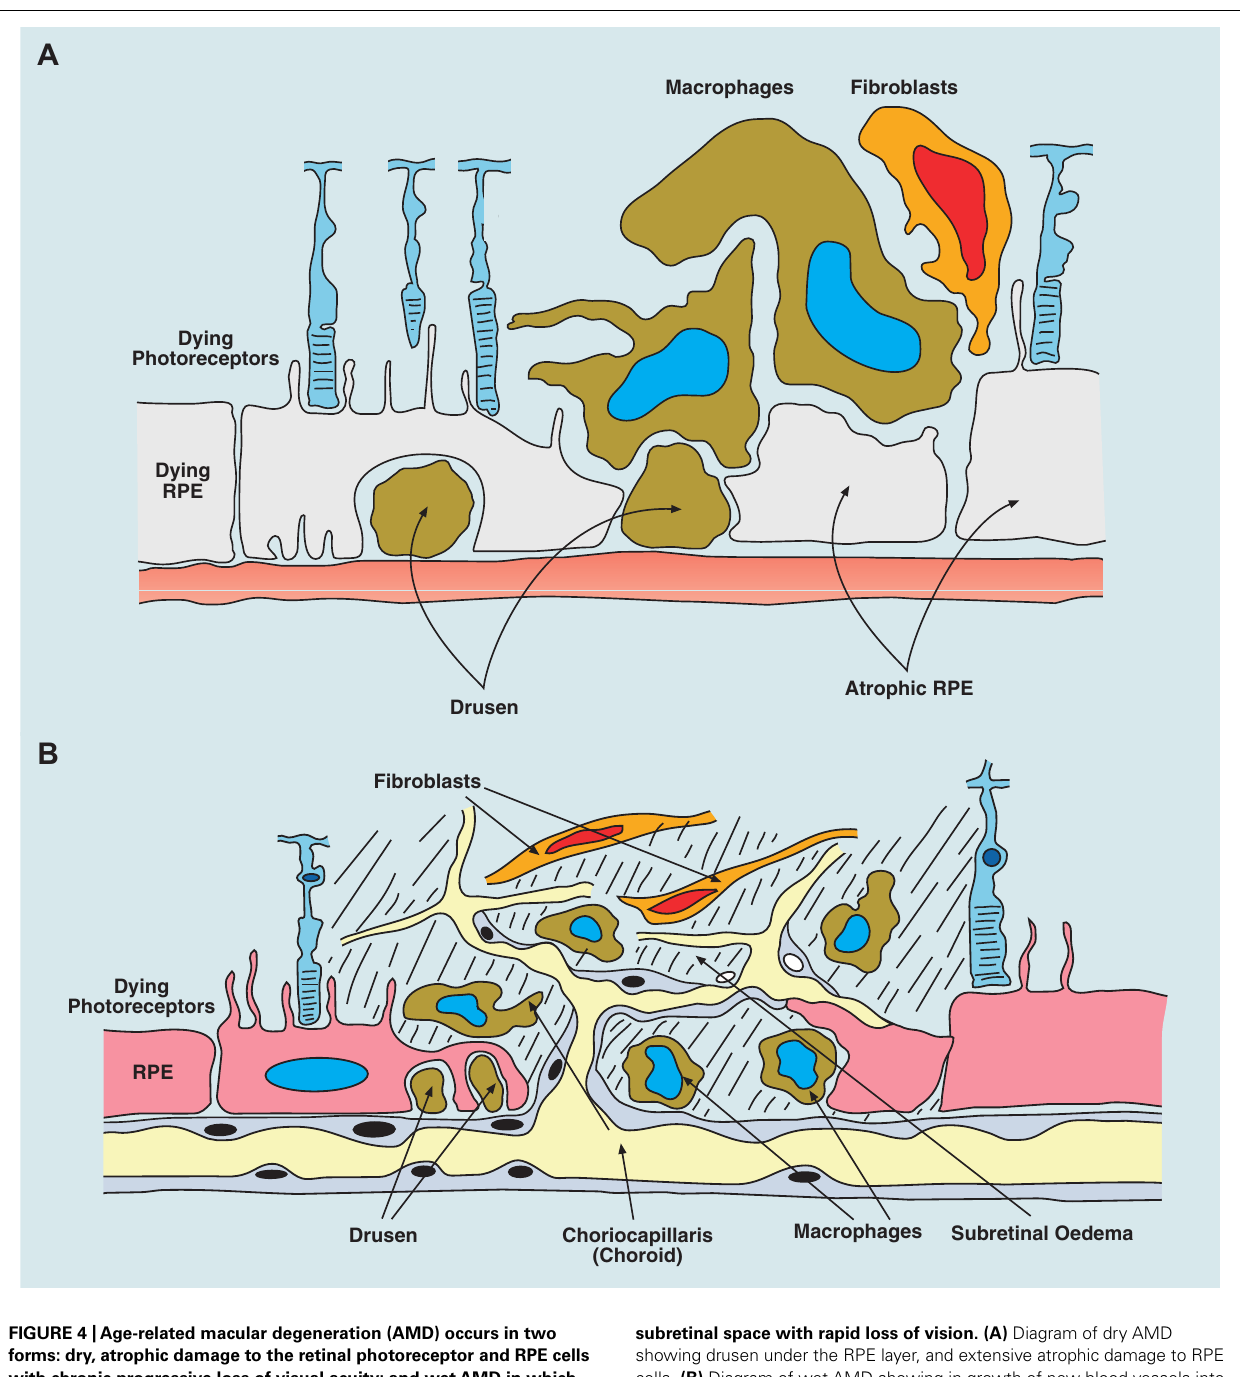
FIGURE 4 |Age-related macular degeneration (AMD) occurs in two forms: dry, atrophic damage to the retinal photoreceptor and RPE cells with chronic progressive loss of visual acuity; and wetAMD in which new vessels originating from the choroidal layer, penetrate the basement membrane of the RPE cells and leak fluid or blood into the